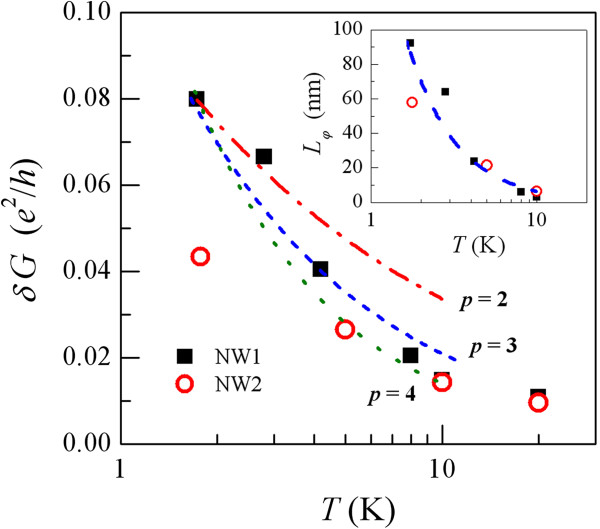
Root-mean-square conductance fluctuation magnitude δGrmsas function of temperature for NW1 and NW2 devices. The dot-dashed, dashed, and dotted curves are the theoretical predictions of Equation 1 with the exponent of temperature p = 2, 3, and 4, respectively, for the electron-phonon relaxation rate 1/τep = AepTp. The inset shows the extracted electron dephasing length Lφ as a function of temperature for the two nanowires. The dashed curve indicates a T3 temperature dependence. The data points at 10 K could be subject to large uncertainties and are only drawn for reference.